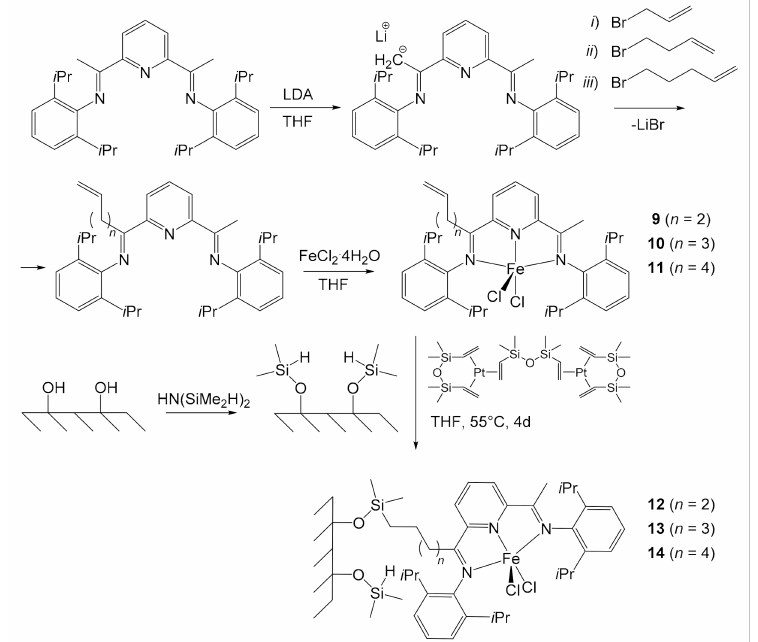
Figure 3. Herrmann’s functionalization of the iron pre-catalyst in three steps and immobilization on modified silica surface using the platinum-based Karstedt catalyst